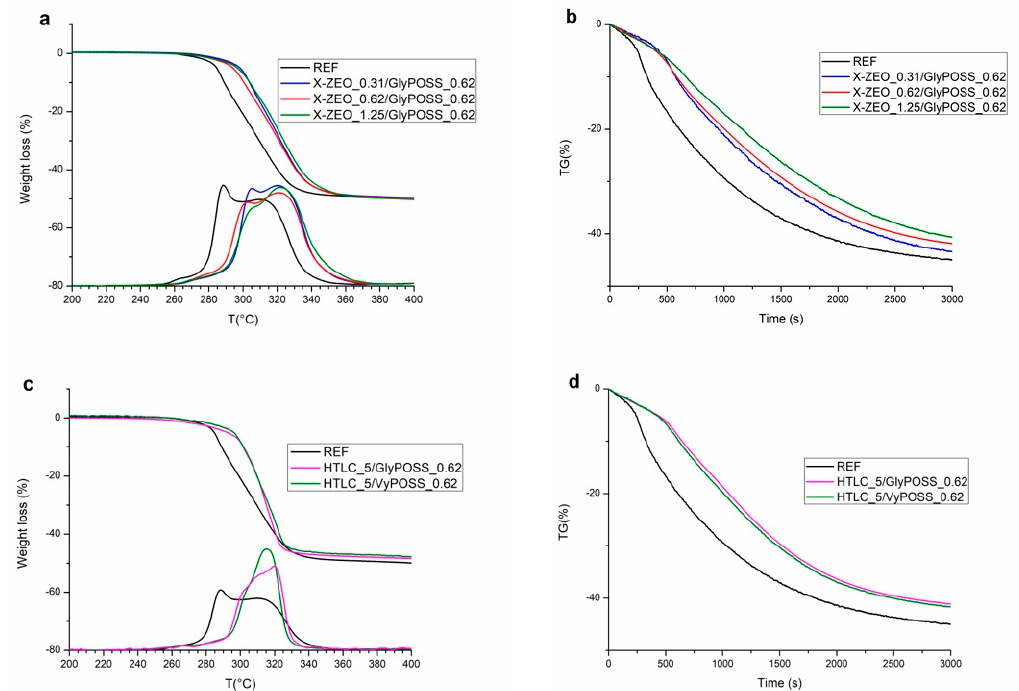
Figure 4. TGA analyses of ( a,b ) REF and X-type zeolite / POSS (0.31–1.25 phr); ( c,d ) P-PVC and of REF and HTLC / POSS P-PVC formulations in the compositional range 0.62–5 phr in ramp ( a , c ) and isothermal conditions ( b , d ).